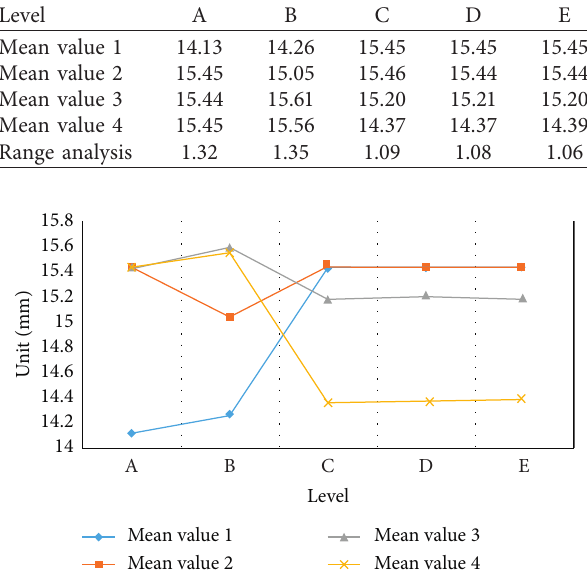
Figure 10: Mean analysis of volume